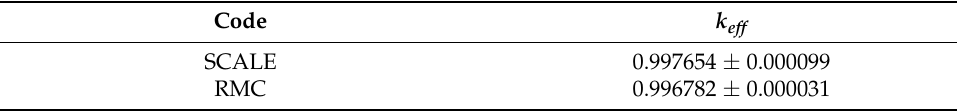
Table 2. SCALE code and RMC code k eff calculation